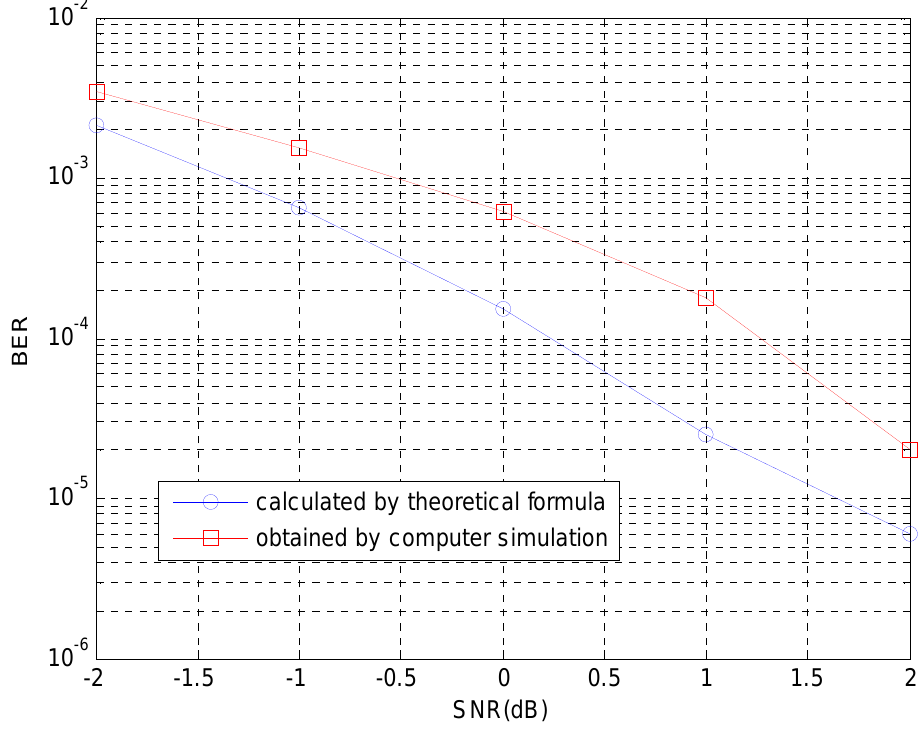
Figure 5. The BERs comparison between calculated by theoretical formula and obtained by computer simulation.